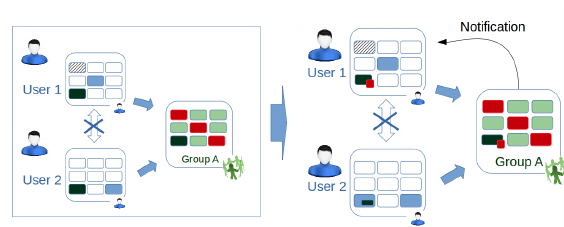
Figure 6. Relaxing global